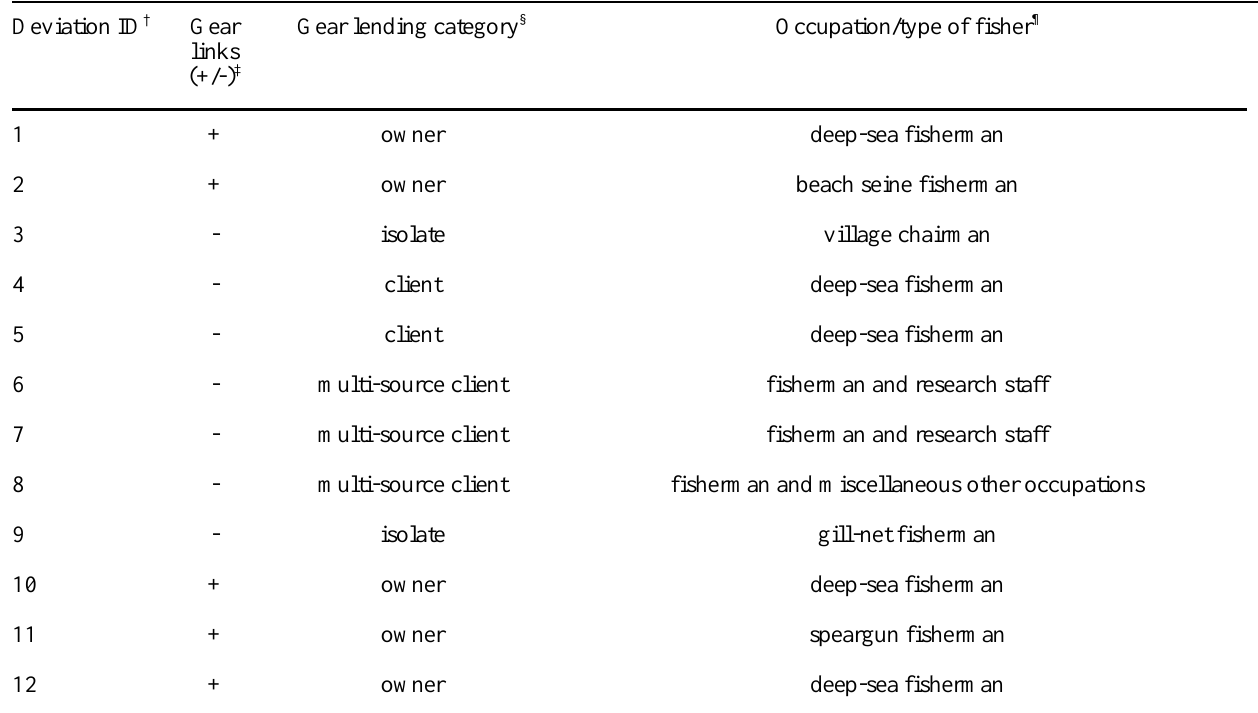
Table 4 . List of individuals who deviate from the correlation between knowledge and gear exchange